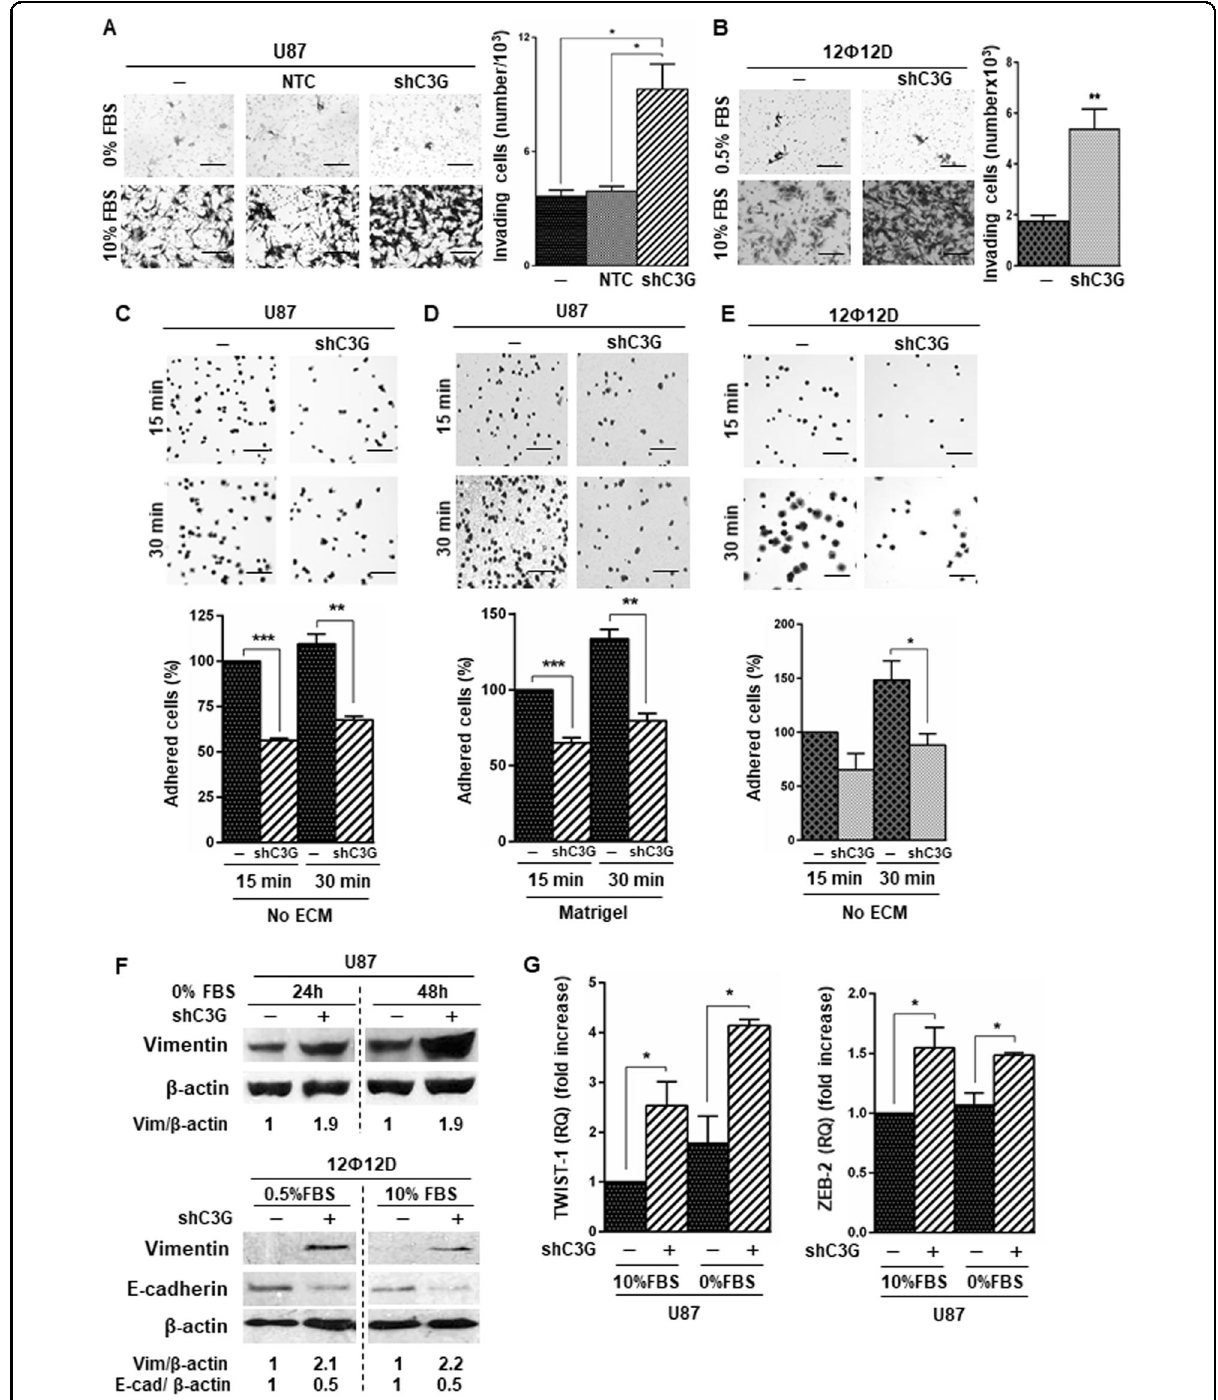
Fig. 2 C3G downregulation enhances invasion of GBM cells promoting the expression of mesenchymal markers. Non-silenced or C3G- silenced (shC3G) U87 and 12 Ф 12D cells, and U87 cells with control shRNA (NTC) have been used. A and B Invasion through Matrigel of U87 and 12 Ф 12D cells (respectively) using FBS as chemoattractant (10%). Left panels, representative images of invading cells; right panels, histograms showing the mean value±S.E.M. of the number of invading cells ( n = 3). C – E Adhesion analysis at 15 or 30min in U87 and 12 Ф 12D cells. Top panels, phase contrast microscopy representative images of adhered U87 cells on uncoated dishes (no ECM) or coated with Matrigel; lower panels, histograms showing mean value±S.E.M. of the percentage of adhered cells referred to non-silenced cells at 15min ( n = 3). * p ≤ 0.05, ** p ≤ 0.01 and *** p ≤ 0.001, compared as indicated. Scale bars ( A – E ): 100µm. F Representative western-blot analyses of Vimentin and E-cadherin levels normalized to β -actin in U87 (upper panel) and 12 Ф 12D cells (lower panel) treated as indicated ( n = 3). G TWIST1 and ZEB2 mRNA levels in U87 cells maintained either in the presence ( + ) or absence ( − ) of serum. Histograms represent RQ mean value±S.E.M. referred to parental cells maintained with 10% FBS ( n = 2 – 4). * p ≤ 0.05, compared as